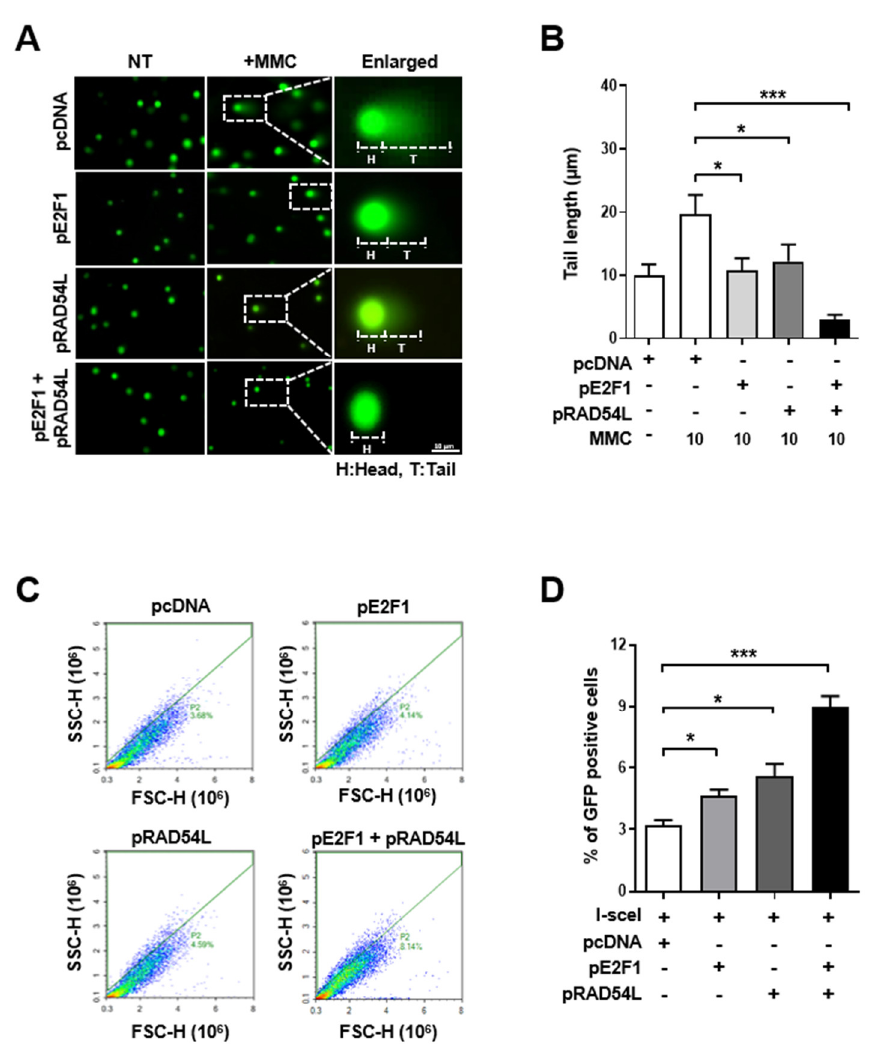
Figure 5. RAD54L and E2F1 increase HR recovery activity when DSB is induced in BC cells. ( A ) Cells transfected with E2F1, RAD54L, or both plasmids were exposed to 10 µ M mitomycin C for 4 h before the comet assay was performed. DNA damage was quantified based on tail length. (H, head of comet; T, tail of comet, Scale bar: 10 µ m). ( B ) Tail length, ( C ) HR assay by U2OS DR-GFP. ( D ) HR frequency expressed as a percentage of GFP-positive cells in viable whole cell population. Data are presented as mean ± SD. *, P < 0.05; ***, P <